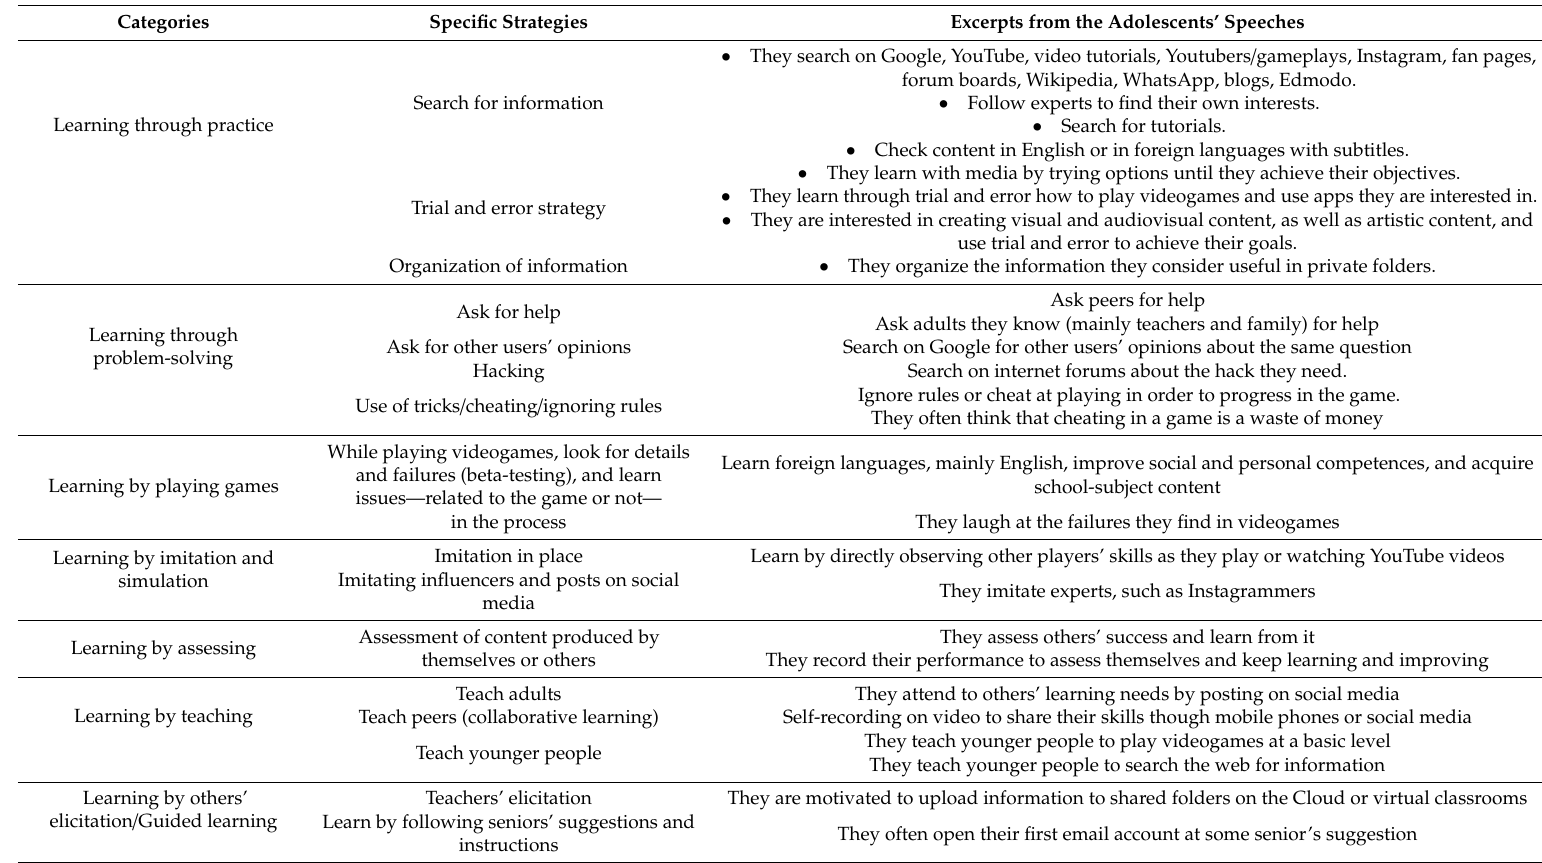
Table 3. Categories of informal learning strategies